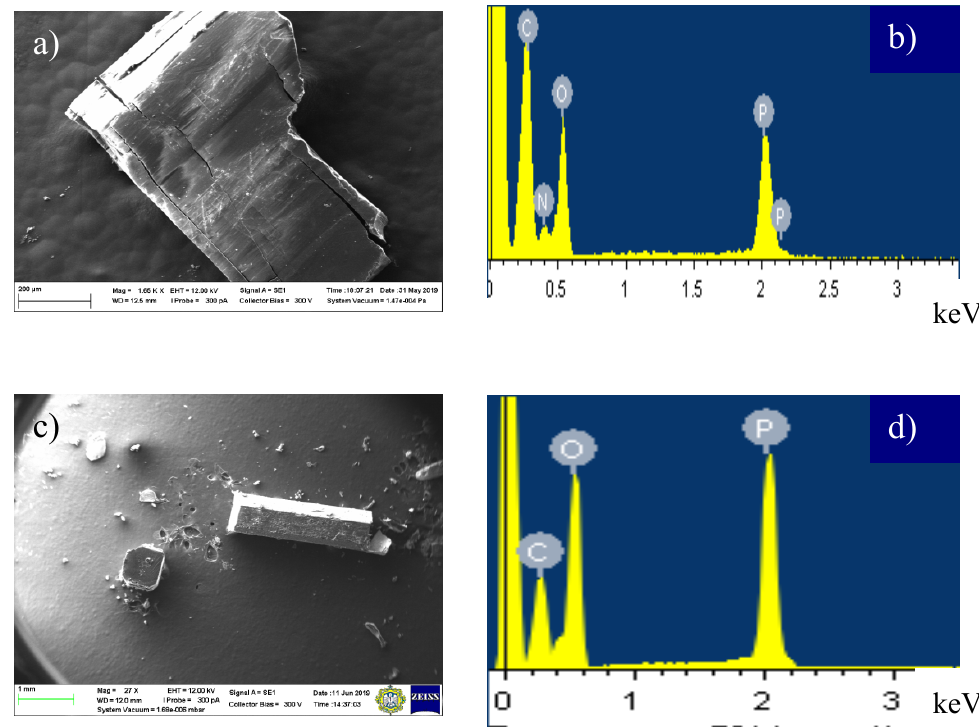
Figure 7. The images of MBI-phosphite ( a ) and MBI-phosphate-2 ( c ) single crystals, obtained by SEM, X-ray spectroscopy (EDX) spectra of MBI-phosphite ( b ) and MBI-phosphate-2 ( d ), respectively.